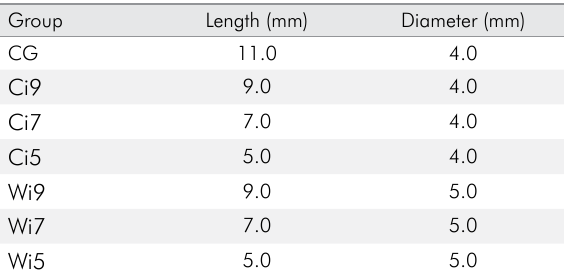
Table 1. Groups distribution in accordance with length and